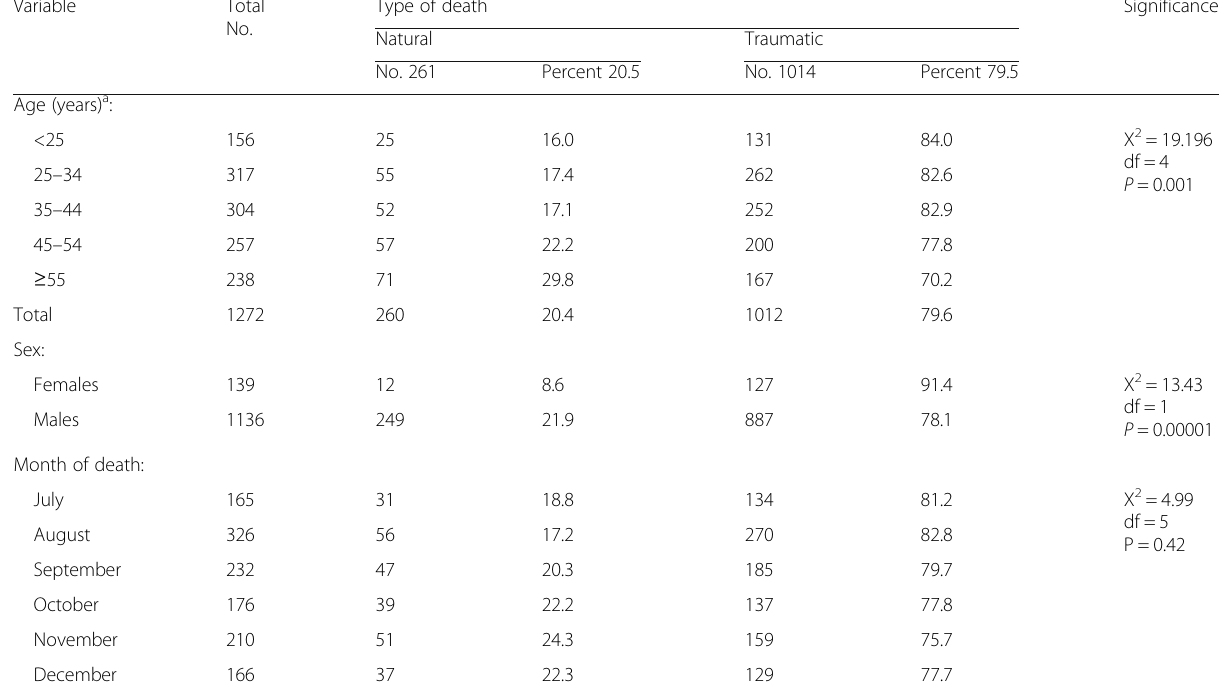
Table 3 Relation of type of death with the studied variables